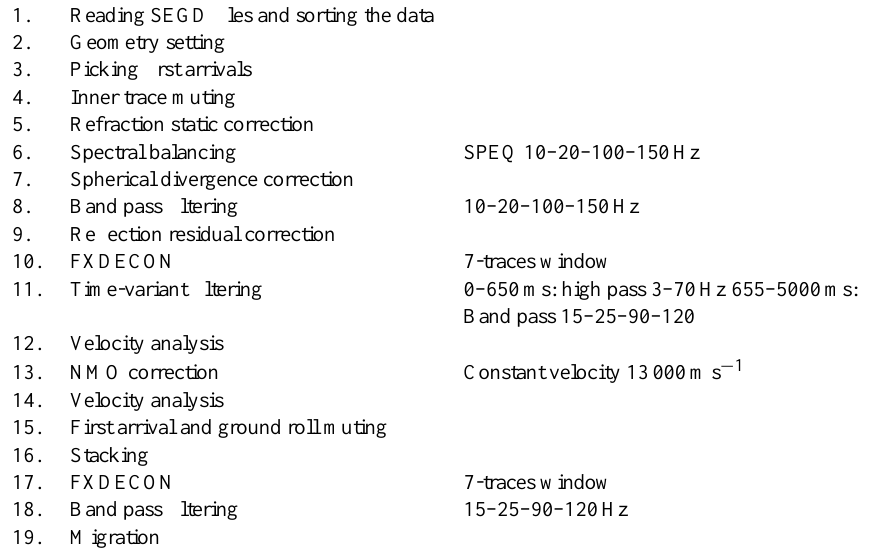
Table 2. Seismic data processing